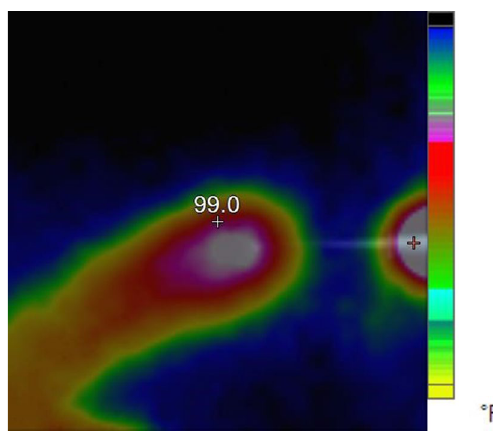
Figure 5. Thermal image of APJCE colliding with